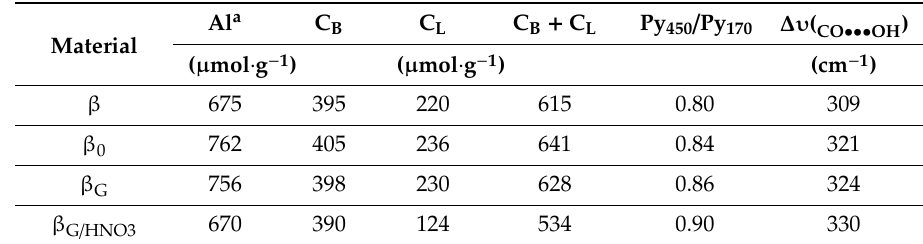
Table 2. The amounts of Al derived from ICP analysis, the concentration of Brønsted (C B ) and Lewis (C L ) acid sites, and the acid strength of the Si(OH)Al groups ∆ υ ( CO ••• OH